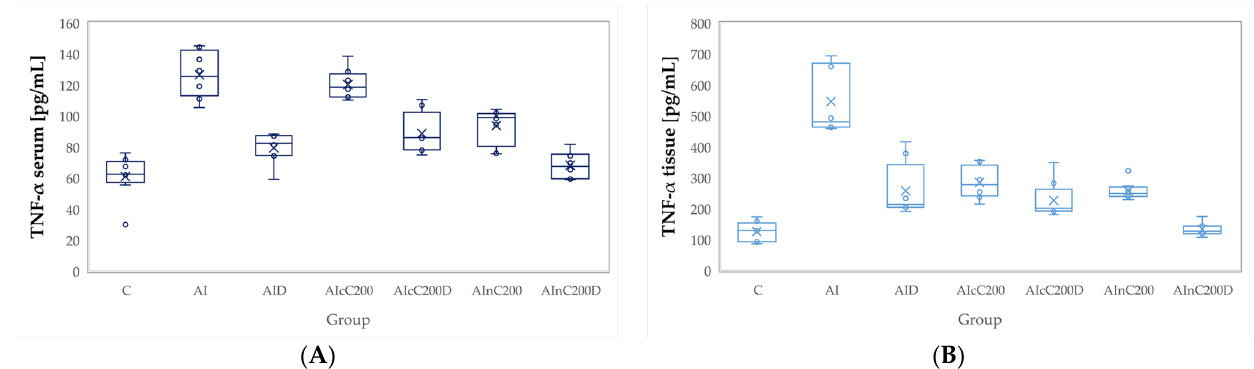
Figure 4. Variation by groups of TNF- α (Tumor necrosis factor α ): ( A ) in the plasma ( B ) in the tissue. C—control; AI—Acute inflammation; D—Diclofenac; cC—conventional curcumin solution (200 mg/kg b.w.); nC—curcumin nanoparticles solution (200 mg/kg b.w).